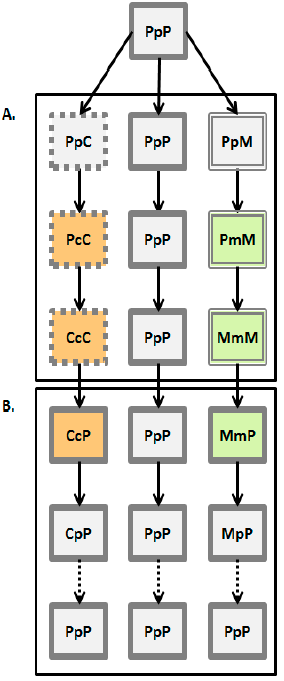
Figure 1. Scheme of the experimental design. Each experimental group had four replicate populations.